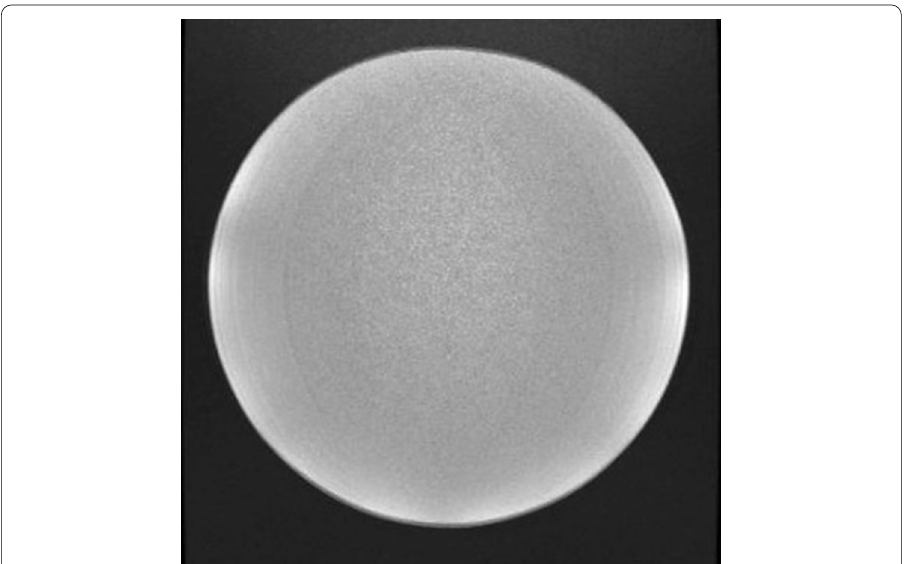
Fig. 3 Cross section of a uniform phantom acquired in MRI (GE Signa PET/MRI